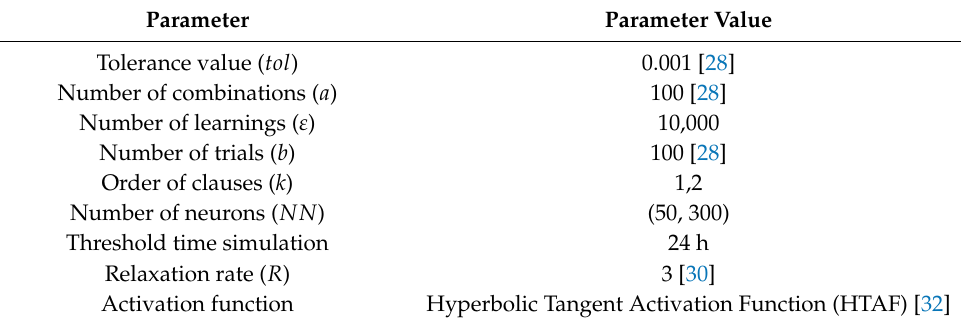
Table 2. List of parameters used in DHNN